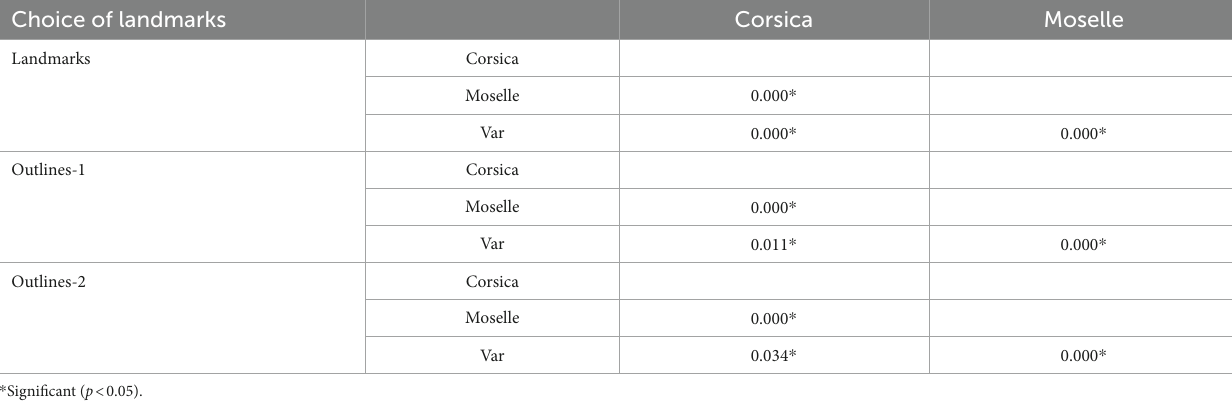
TABLE 2 Non-parametric comparisons of global size estimations, 1,000 permutations ( P -values). Choice of